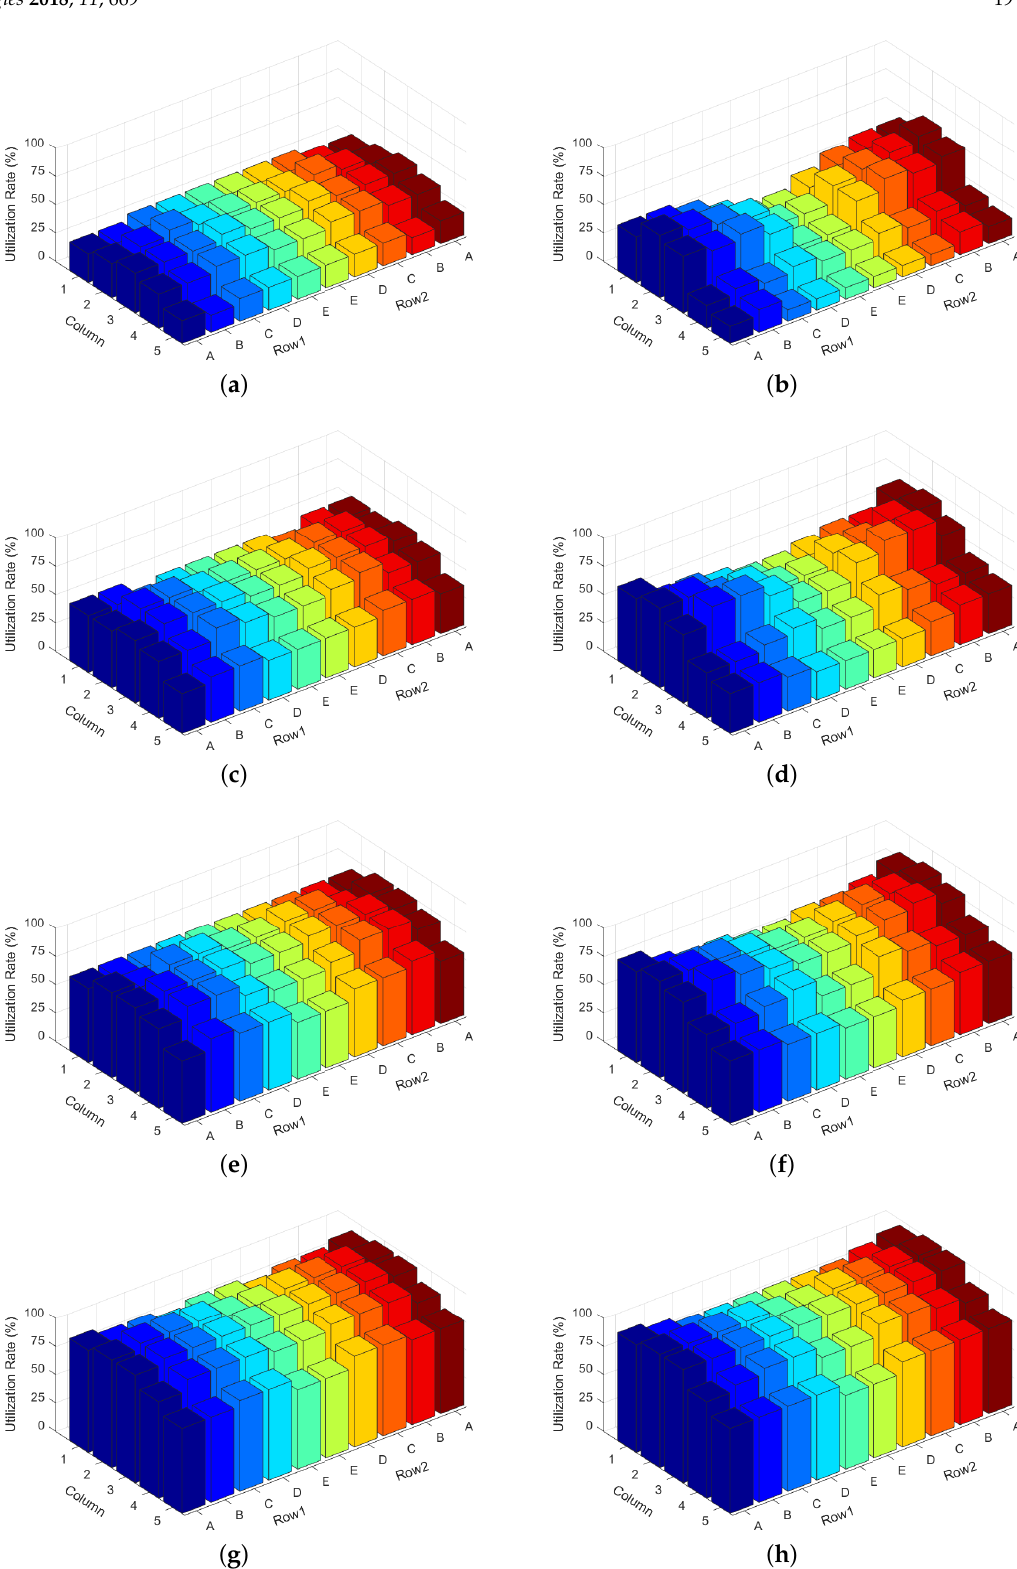
Figure 12. Workload distributions achieved by chip temperature-aware workload allocation